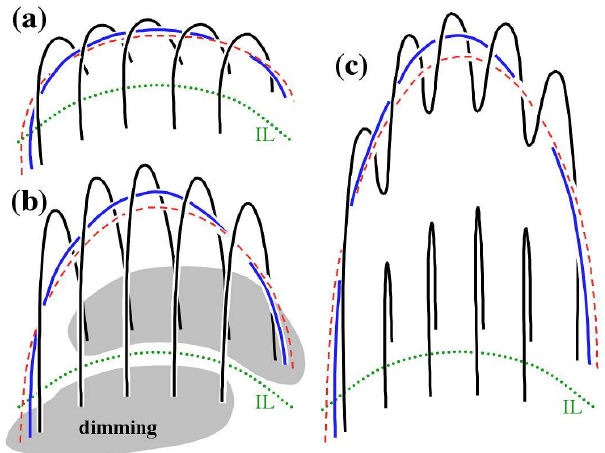
Fig. 13. A scenario for a flux rope eruption. (a) A flux tube (blue and red lines) is embedded in a sheared arcade (black lines). (b) The arcade and the flux rope expand significantly (more than the pressure scale height). Dimmings (grey areas) are formed at the footpoints of the flux rope and also of the sheared arcade. (c) The reconnection of the sheared arcade progressively incorporates more flux to the erupting flux tube. In this scenario the magnetic flux in each dimming corresponds to the sum of the axial and azimuthal flux in the associated MC, in contrast to the ideal case presented in Fig. 10 (Mandrini et al., 2005, 2007). The dotted green line is the magnetic photospheric inversion line